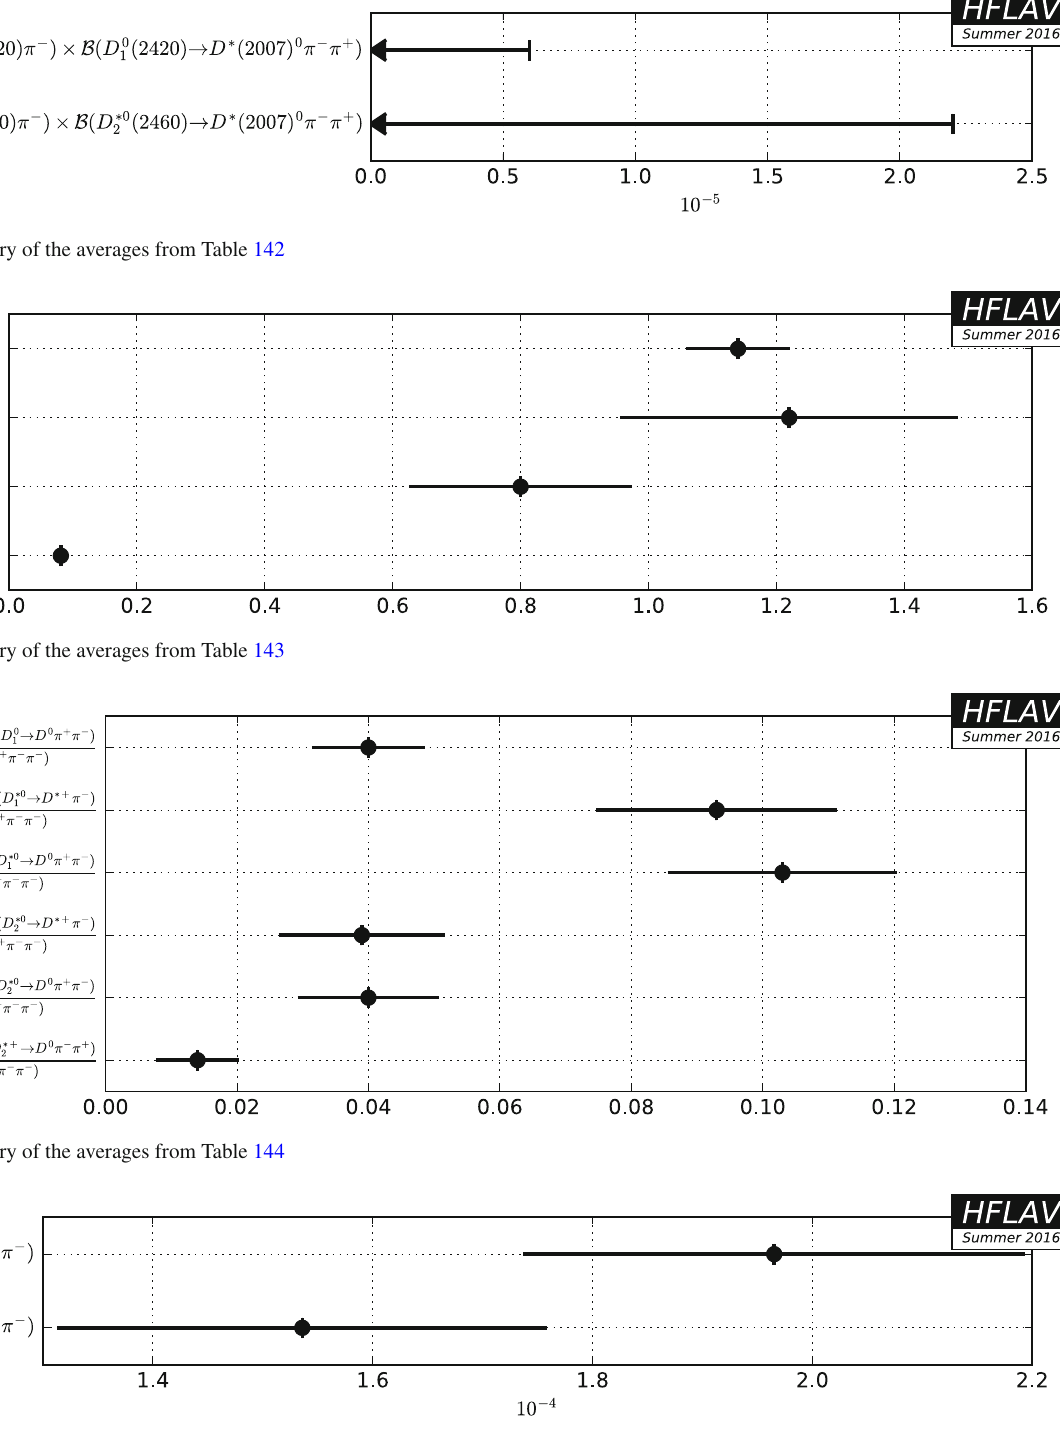
Fig. 115 Summary of the averages from Table